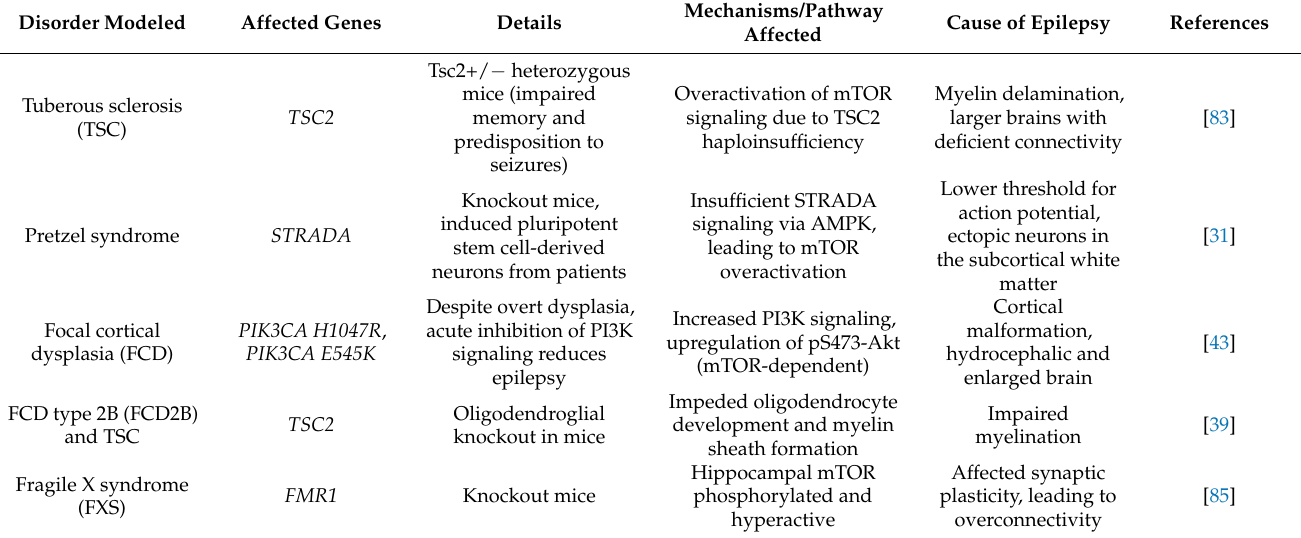
Table 2. Summary of selected rodent models of mTORopathic